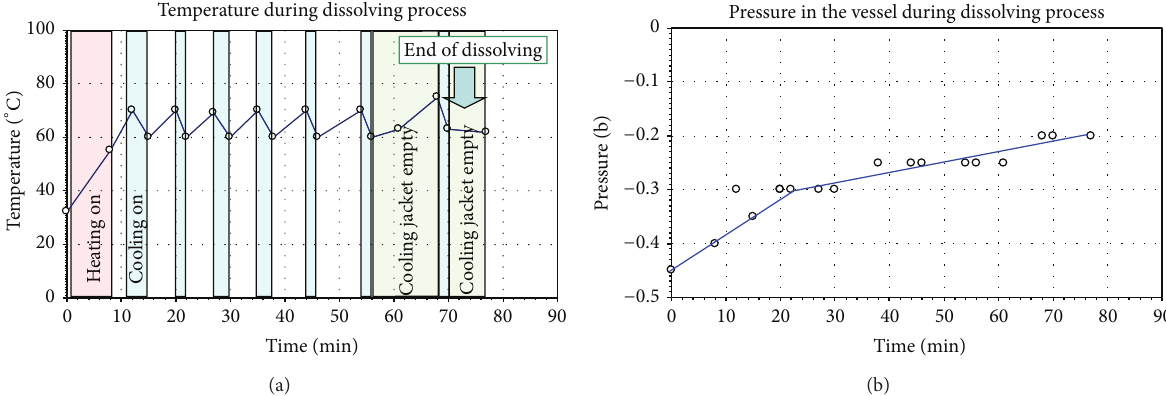
Figure 2: Temperature gain during controlled dissolving process (a) and the pressure situation during the dissolving process (b).